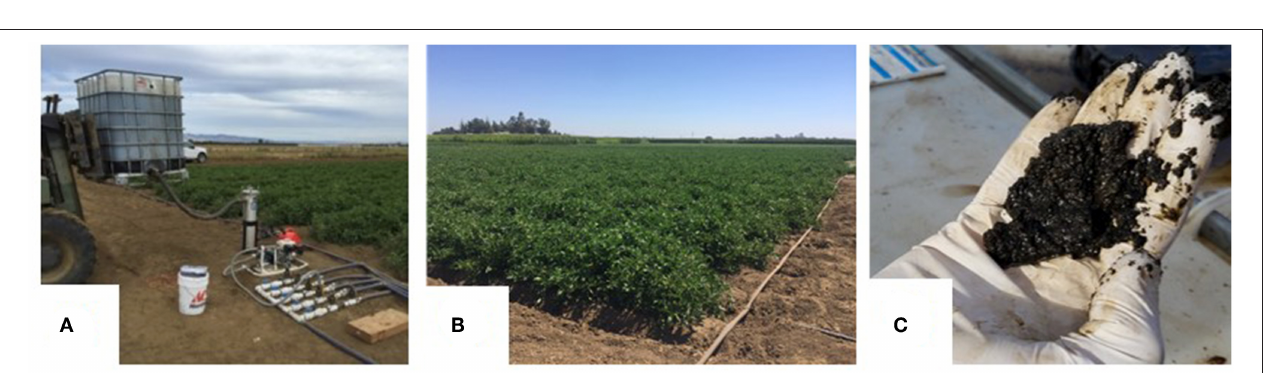
FIGURE 1 | Integrated digestate processing system and biofertilizer application.